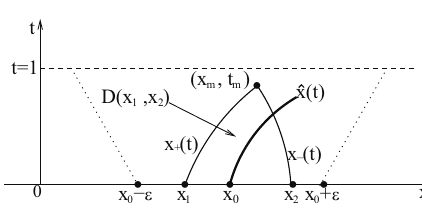
Figure 1: The characteristic triangle region ( ) D x x , 1 2